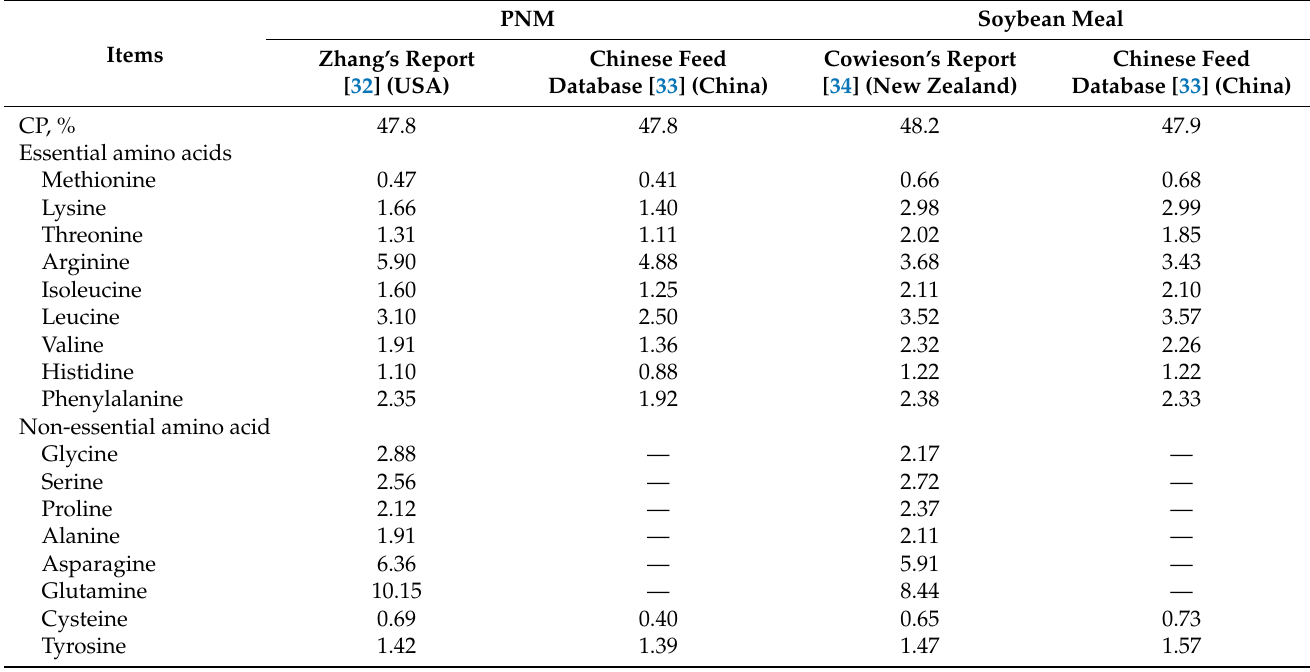
Table 2. The contents of amino acids in PNM and soybean meal reported in various